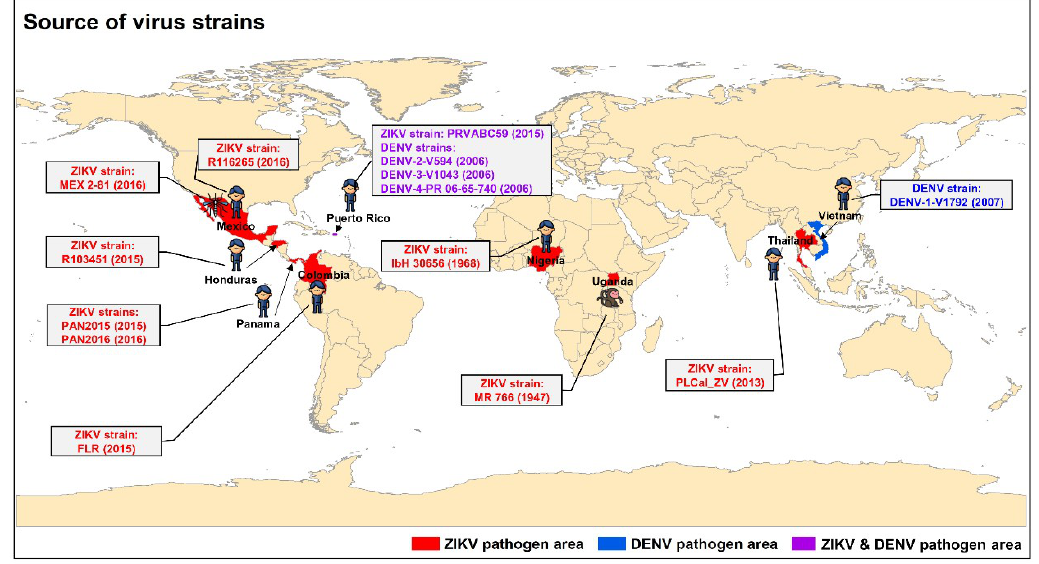
Figure 1. Schematic map for the source of Zike virus (ZIKV) and dengue virus (DENV)-1–4 strains used in the studies. ZIKV only, DENV only, and ZIKV–DENV coinfections are shown in red, blue, and purple, respectively. Countries with isolated ZIKV and DENV strains from different hosts (human, mosquitos, and monkeys) are illustrated. The letters in parentheses indicate the year of ZIKV or DENV isolation.